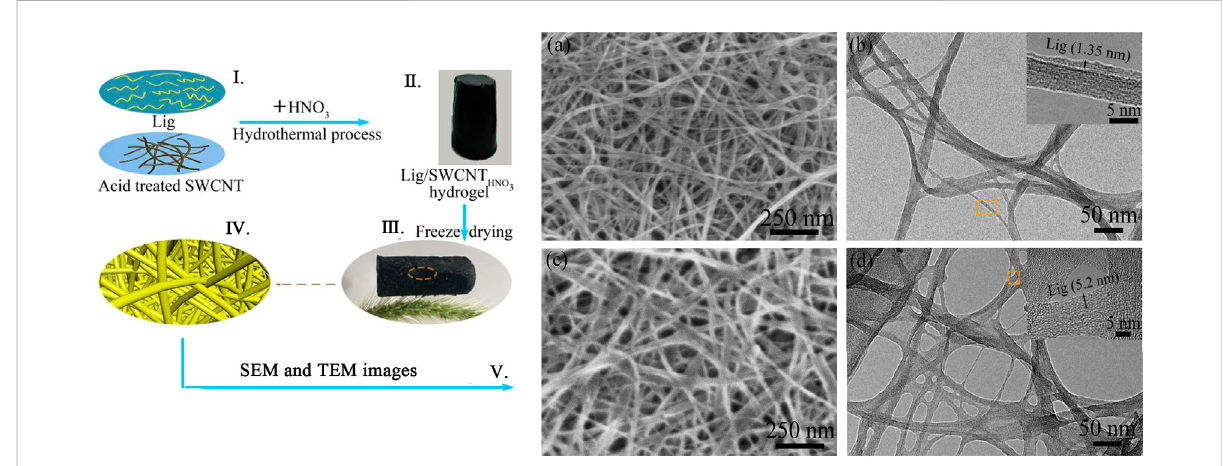
FIGURE 6 ( Ⅰ – Ⅳ ) Aerogel assembled by Lig (lignosulfonate) and acid treated SWNCT (single-walled carbon nanotubes). ( Ⅴ ) SEM and TEM images of Lig/ SWCNT and Lig/SWCNT HNO3 . Adapted with permission from Peng et al.